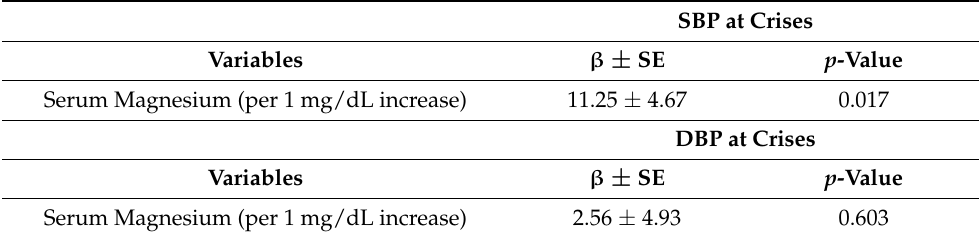
Table 3. Association of serum magnesium and SBP at crises or DBP at crises using linear model analysis (adjusted for covariates) ( N =